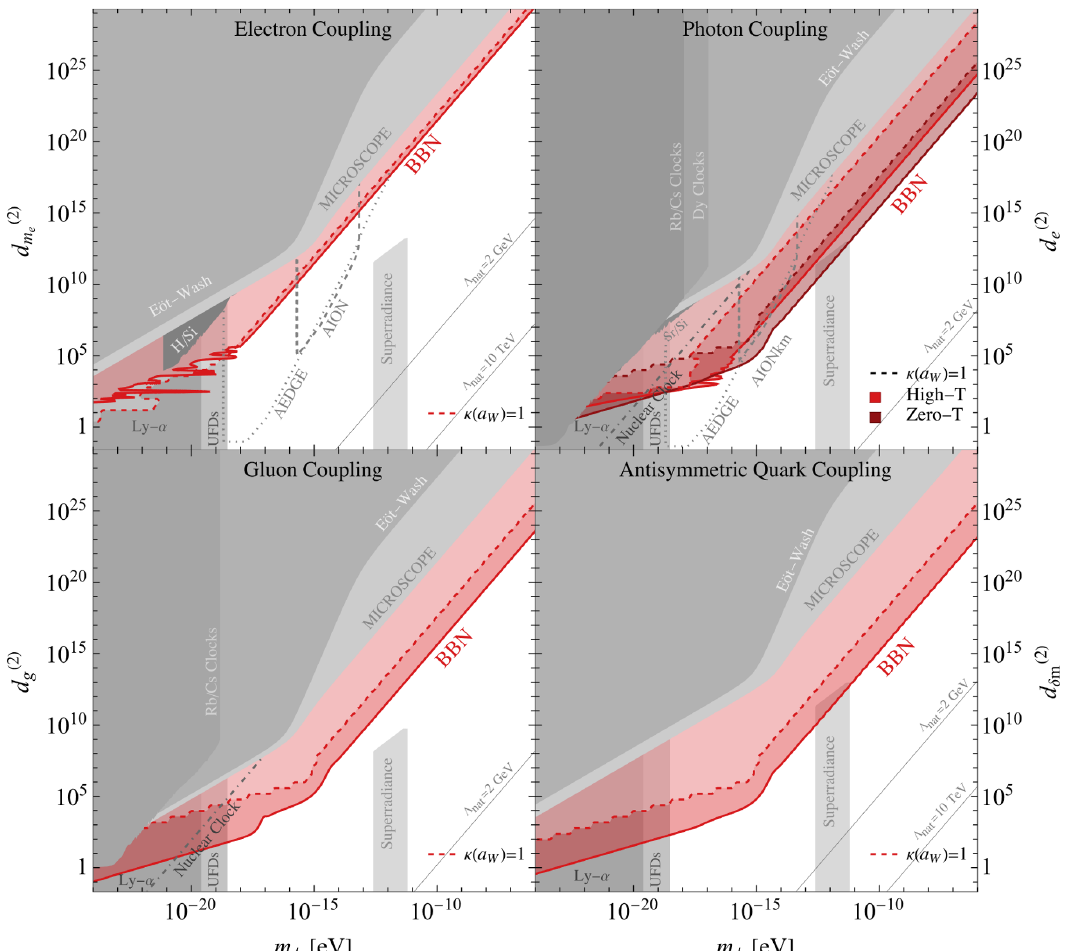
Figure 3 . Constraints on quadratic couplings of ULDM to electrons, quarks, gluons, and photons. Red regions indicate the BBN constraints derived in this paper. Other constraints are given in shades of gray. On the photon coupling plot, the conservative high-temperature approximation of the thermal mass yields the constraint in lighter red while the optimistic zero-temperature (i.e., without backreaction) result yields the constraint in darker red, see section 2.1.2 for details. The dashed red lines indicate where the approximation used in this paper breaks down and a more detailed analysis is needed. The grey regions show parameter space ruled out by prior work from the Eöt-Wash [9] and MICROSCOPE [49] experiments, atomic clock experiments [31, 50] as well as constraints from Lyman- α [2], UFDs [3] and superradiance [23, 51]. Also shown, with dashed gray lines, are projected constraints from the AION and AEDGE experiments [52, 53] as well as projections for nuclear clocks [54]. Following the discussion in section 2, we show the line above which the low values of m may be rendered unnatural by large loop corrections, assuming a cutoff φ of Λ = 10 TeV and Λ = 2 GeV. For the gluon and photon plots, the line for a Λ = 10 TeV cutoff lies outside the range